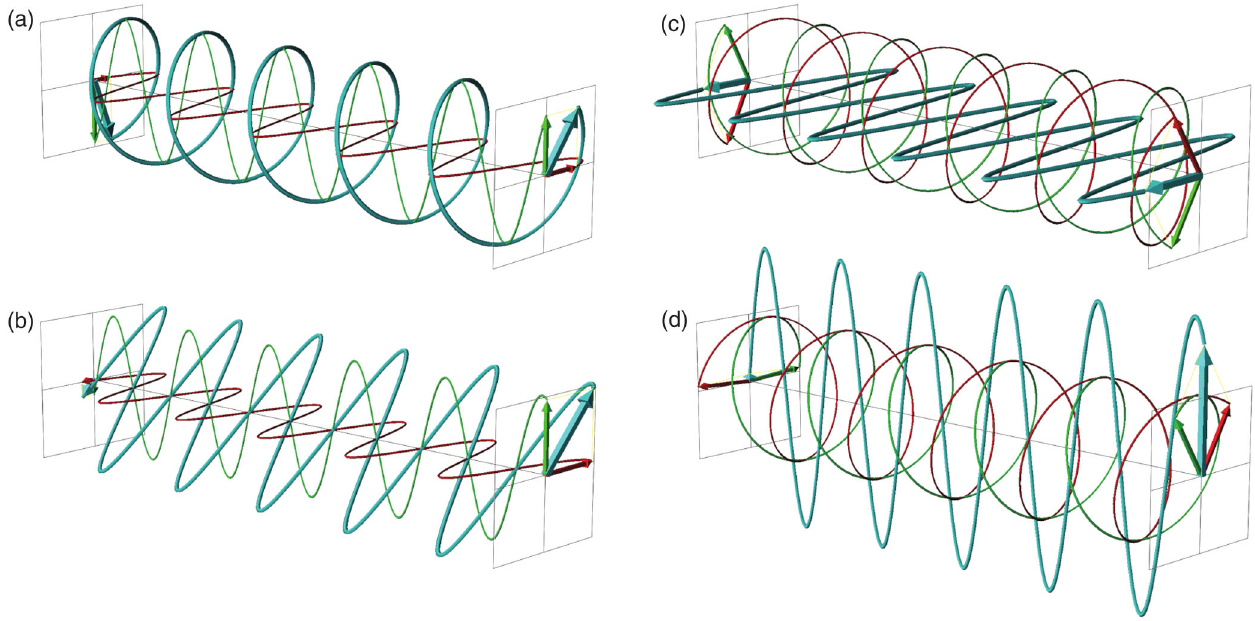
FIG. 1. Schematic depiction of the XPU scheme. (a) and (b) describe the superposition of two linearly polarized sources, LH (red line) and LV (green line) to obtain either circularly polarized, or linear polarization at an arbitrary direction (light blue line). (c) and (d) schematically illustrate the superposition of CR and CL sources (red and green curves, respectively) to produce linearly polarized light with arbitrary direction (light blue curve, along the vertical and horizontal direction in the image). Images obtained using